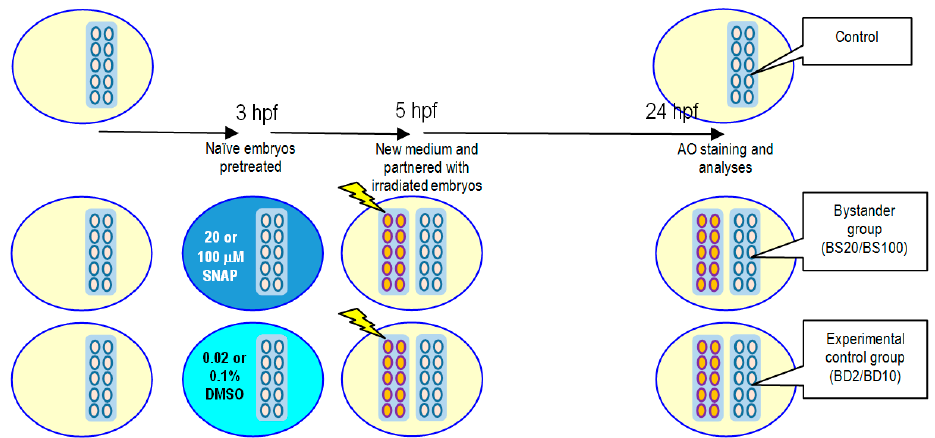
Figure 5. Schematic diagram showing the protocols for studying the influence of SNAP on X-ray-induced non-targeted bystander effects. Naïve embryos were pretreated with 20 or 100 µM SNAP to form the bystander groups BS20 or BS100, respectively, or pretreated with 0.02% or 0.1% DMSO for 2 h at 3 hpf to form the experimental control groups BD2 or BD10, respectively. After pretreatment, the bystander groups and the experimental control groups were transferred to new E3 media and were then partnered for 19 h with embryos already irradiated with 75 mGy of X-ray. The embryos were then incubated at 28.5 °C until 24 hpf for AO staining and analyses.